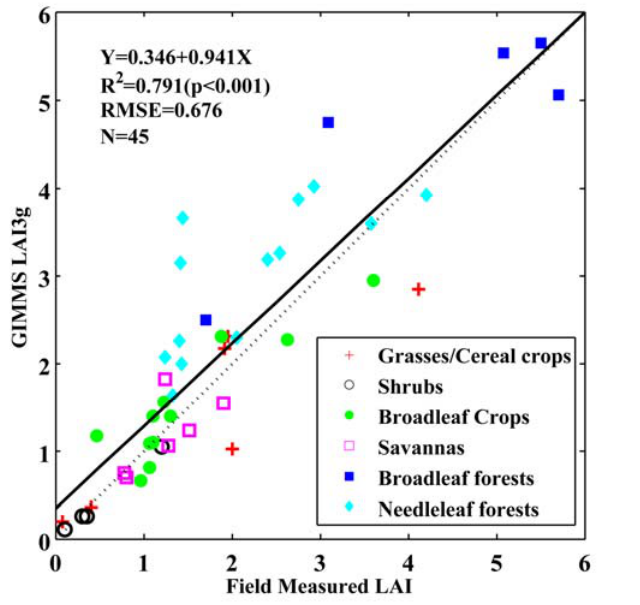
Figure 2. Comparison of LAI3g with scaled field measurements from six biomes representative of the global land cover classes. A total of 45 field data sets from 29 sites listed in Table A4 of [40] were used (details of field data handling to derive LAI values comparable to satellite retrievals of LAI can be found in